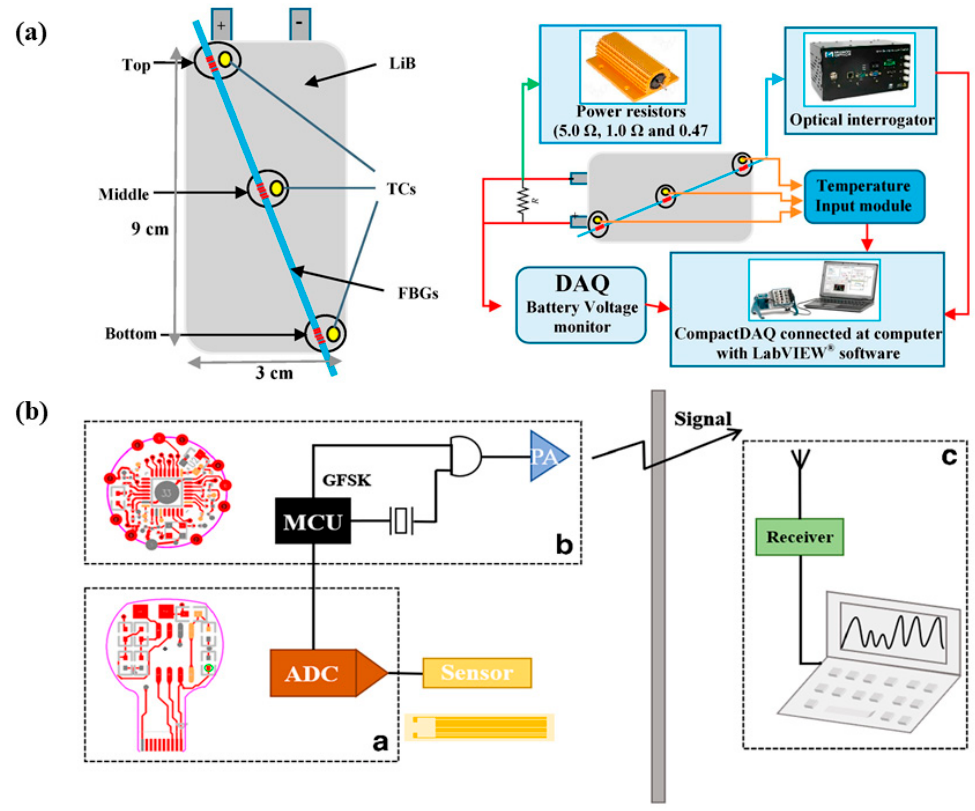
Figure 3. Thermal signal safety monitoring method. ( a ) Optical fiber sensor and thermocouple layout position ( right ) and schematic diagram ( left ) (use LabVIEW® customized application) [71]; ( b ) implantable wireless signal transmission technology [76].